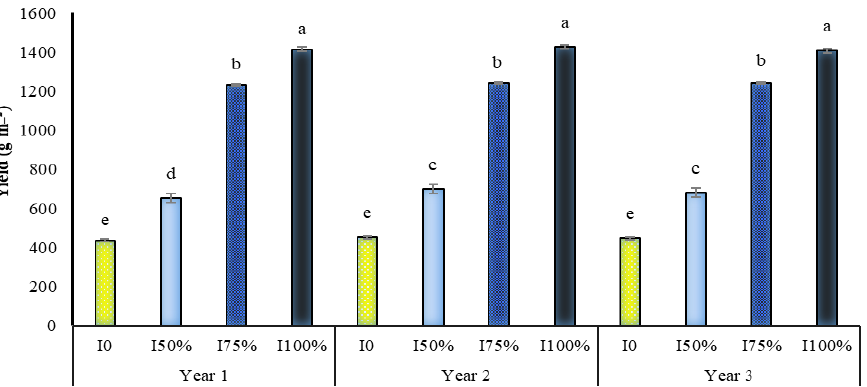
Figure 7. Dual interaction of experimental years (2016–2017, 2017–2018, and 2018–2019) and